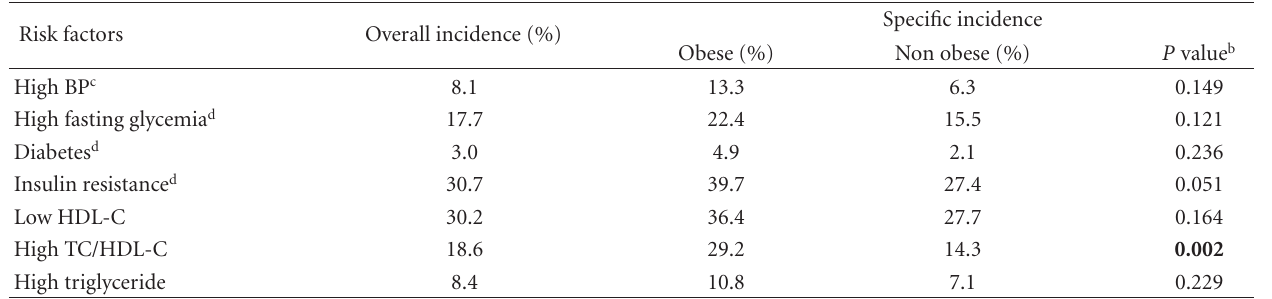
Table 4: Four-year incidence a rate of cardiometabolic risk factors according to baseline abdominal obesity status ( n = 366). Risk